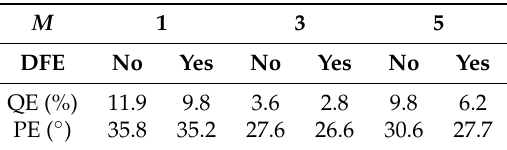
Table 4. Performance Predictions of binaural Ambisonic rendering using the Sagittal Plane Localisation Model [44], with and without